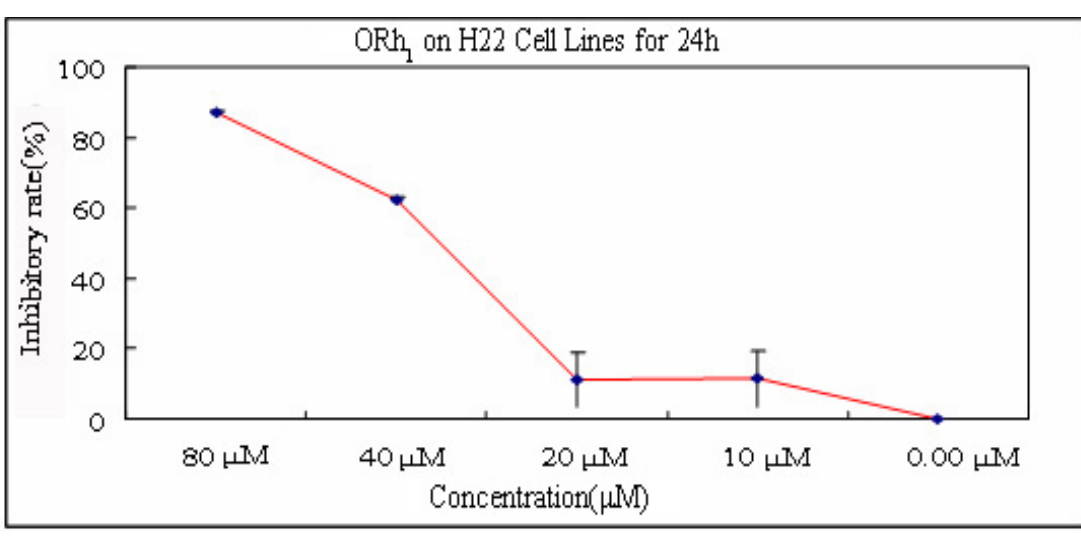
on H22 cell lines after 24 1